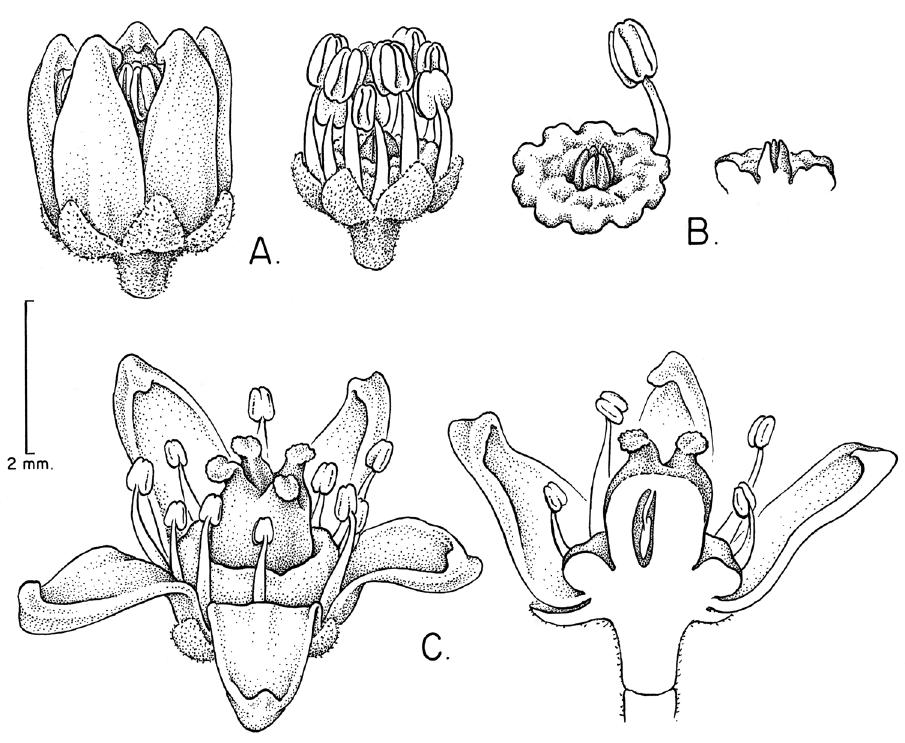
Figure 14. Flowers of Spondias purpurea. A Staminate flower at anthesis (left), and same with corolla removed B Disk, staminode, and stamen C Pistillate flower at anthesis (left), and same in longisection through center plus articulated pedicel. A–B from Sidwell et al. 589 (NY) C from Daly 137